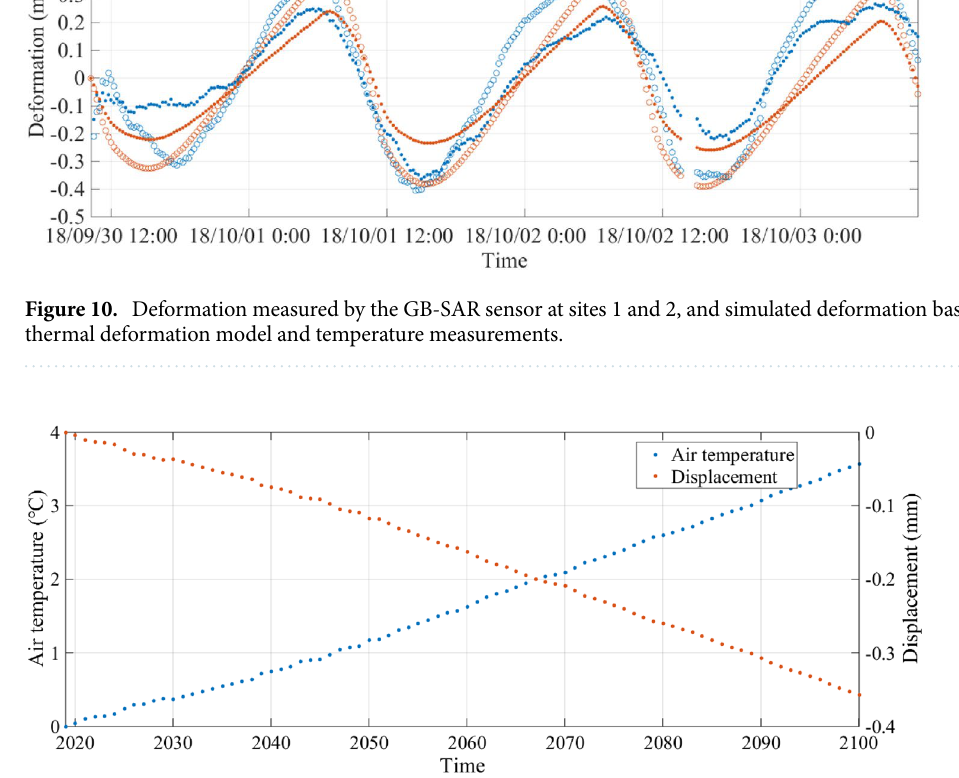
Figure 11. Projected air temperature and deformation of the loess slope on 15 January of each year from 2020 to 2100, referenced to 2020. Negative values indicate deformation toward the GB-SAR sensor (expansion of